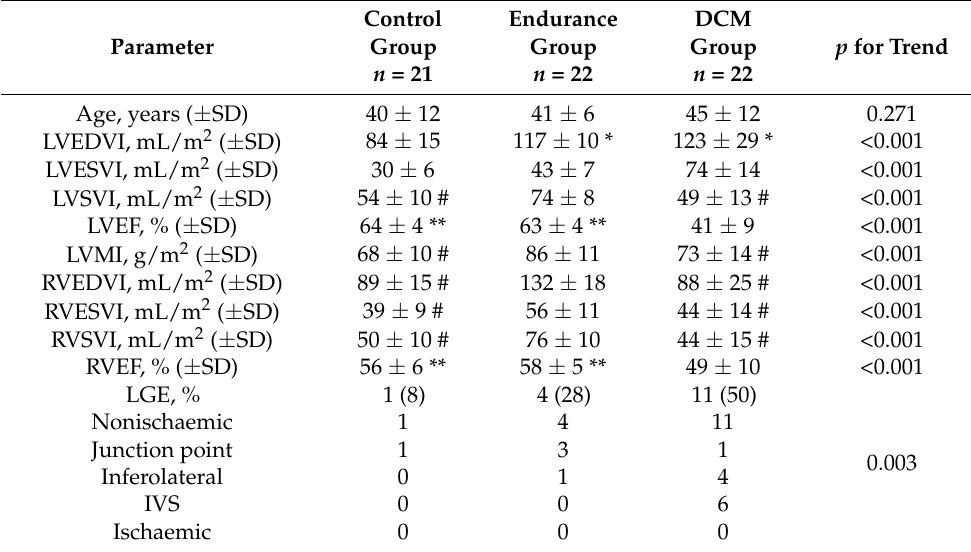
Table 1. Baseline cardiac magnetic resonance (CMR) parameters in studied groups.